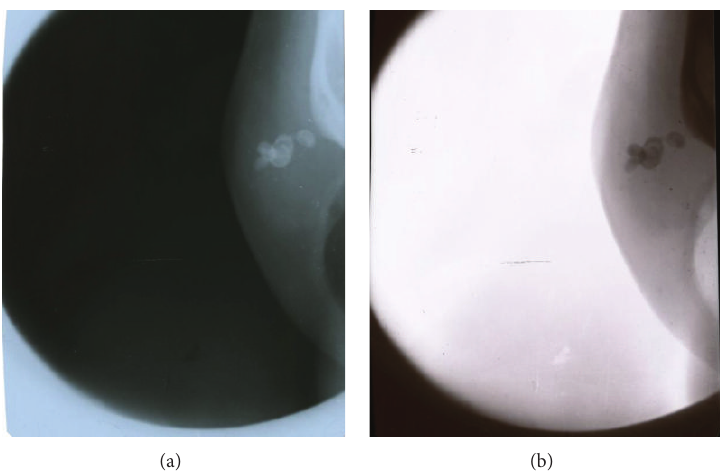
Figure 3: Puffed cheek radiograph and its inverted image depicting the calcifications noted within the lesion.